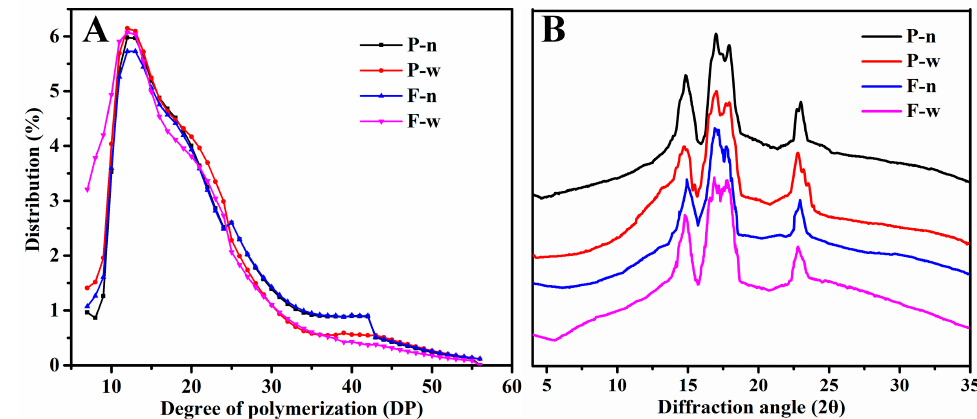
Figure 3. Amylopectin chain length distribution ( A ) and X-ray diffraction (XRD) patterns ( B ) of starches.